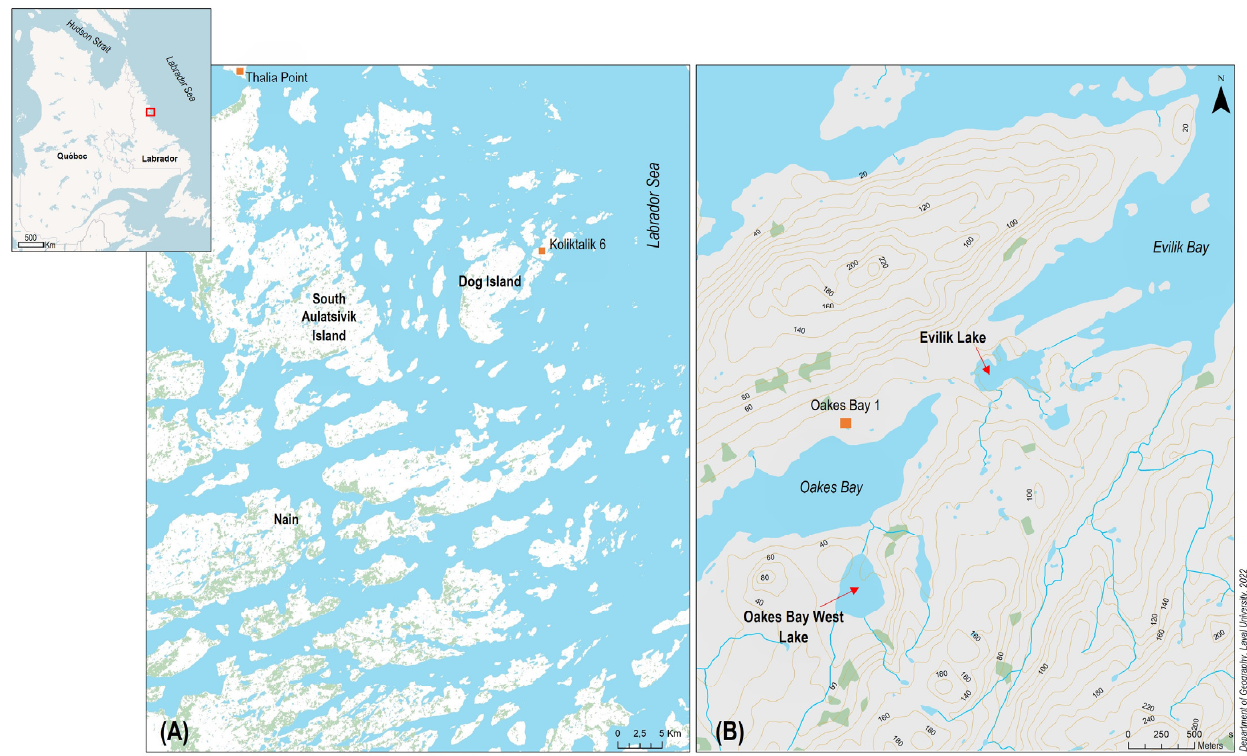
Figure 1. Location of the study site on the Labrador coast, Canada. ( A ) Nain and its Archipelago; ( B ) northern part of Dog Island showing sampled lakes, elevation (meters), and Oakes Bay 1 archae- ological site.